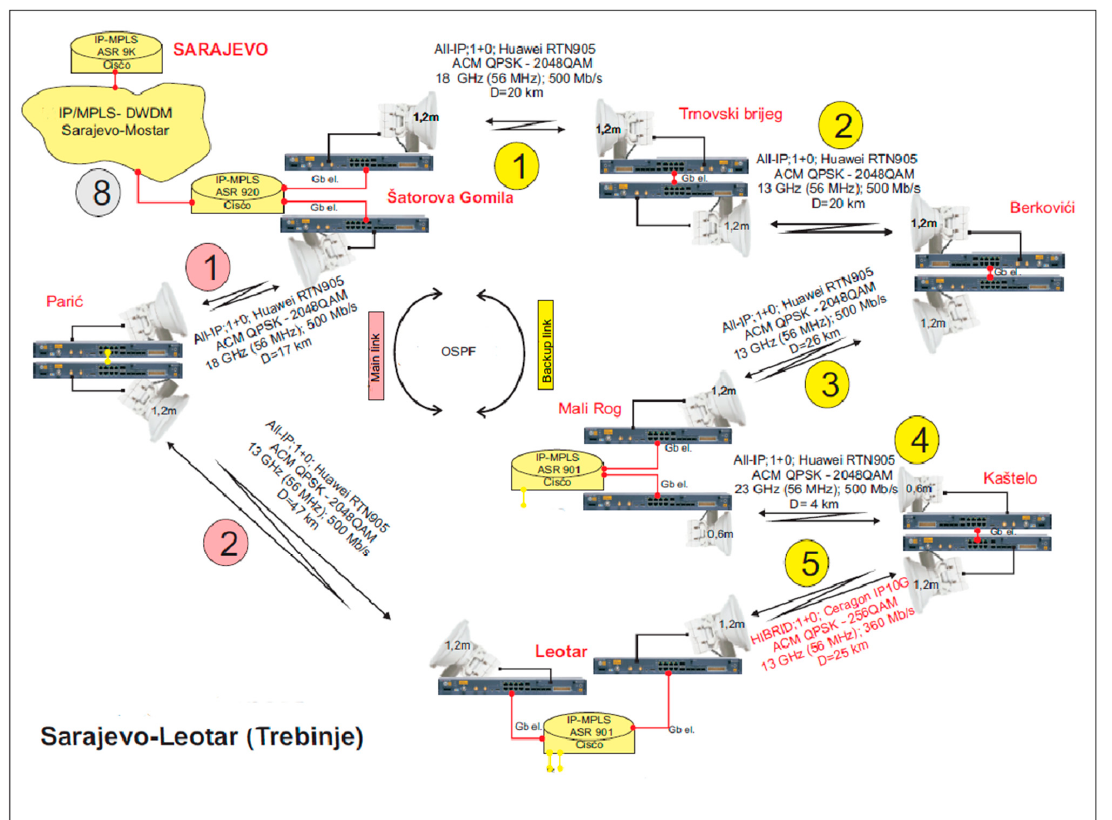
Figure 5. RR system under test: Šatorova Gomila–Trnovski Brijeg–Berkovi ć i–Mali Rog–Kaštelo–Leotar.